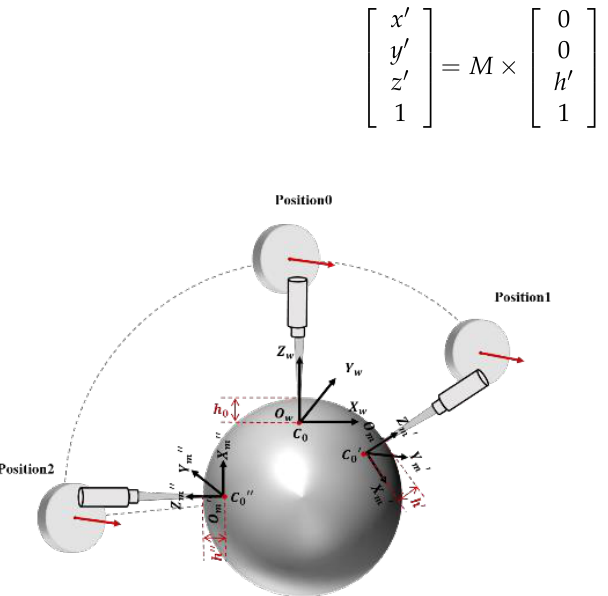
Figure 7. The system calibration model.